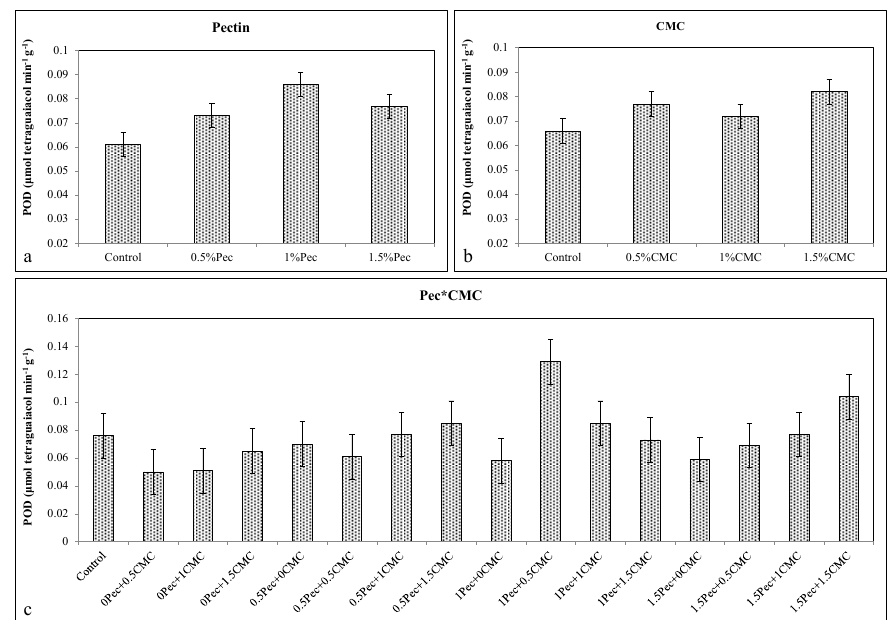
Figure 10. Effect of 0 (control), 0.5 (0.5% Pec), 1 (1% Pec) and 1.5 (1.5% Pec) % pectin-based edible coatings ( a ), 0 (control), 0.5 (0.5% CMC), 1 (1% CMC) and 1.5 (1.5% CMC) % carboxymethylcellulose-based edible coatings ( b ) and their combinations ( c ) on peroxidase (POD) enzyme activity during cold storage period. Data are the “estimated marginal means ±95% confidence intervals”. The results were expressed on a fresh weight basis. The columns with non-overlapping error bars are significantly different ( p ≤ 0.05).